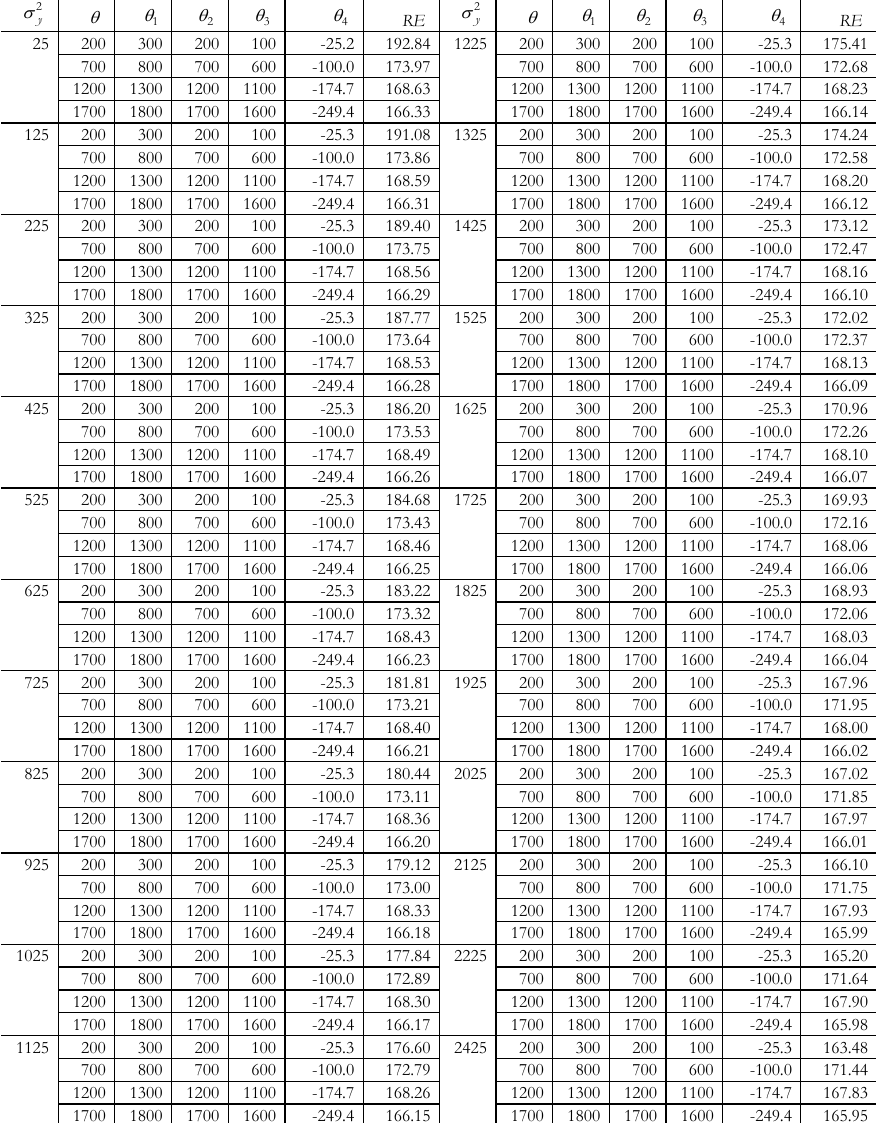
Relative efficiency of the POONAM estimator over the GS